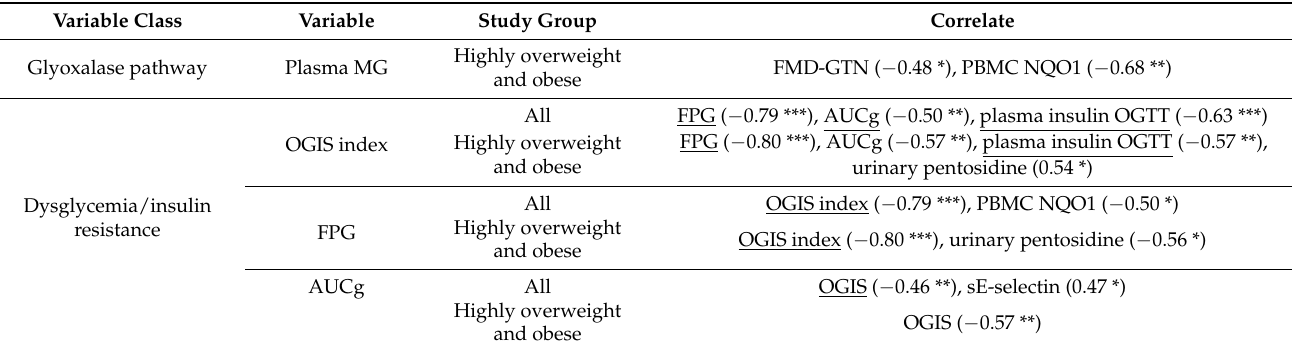
Table 2. Correlation of changes of glyoxalase and dysglycemia/insulin resistance-related variables in the tRES-HESP and placebo treatment periods of the HATFF study.